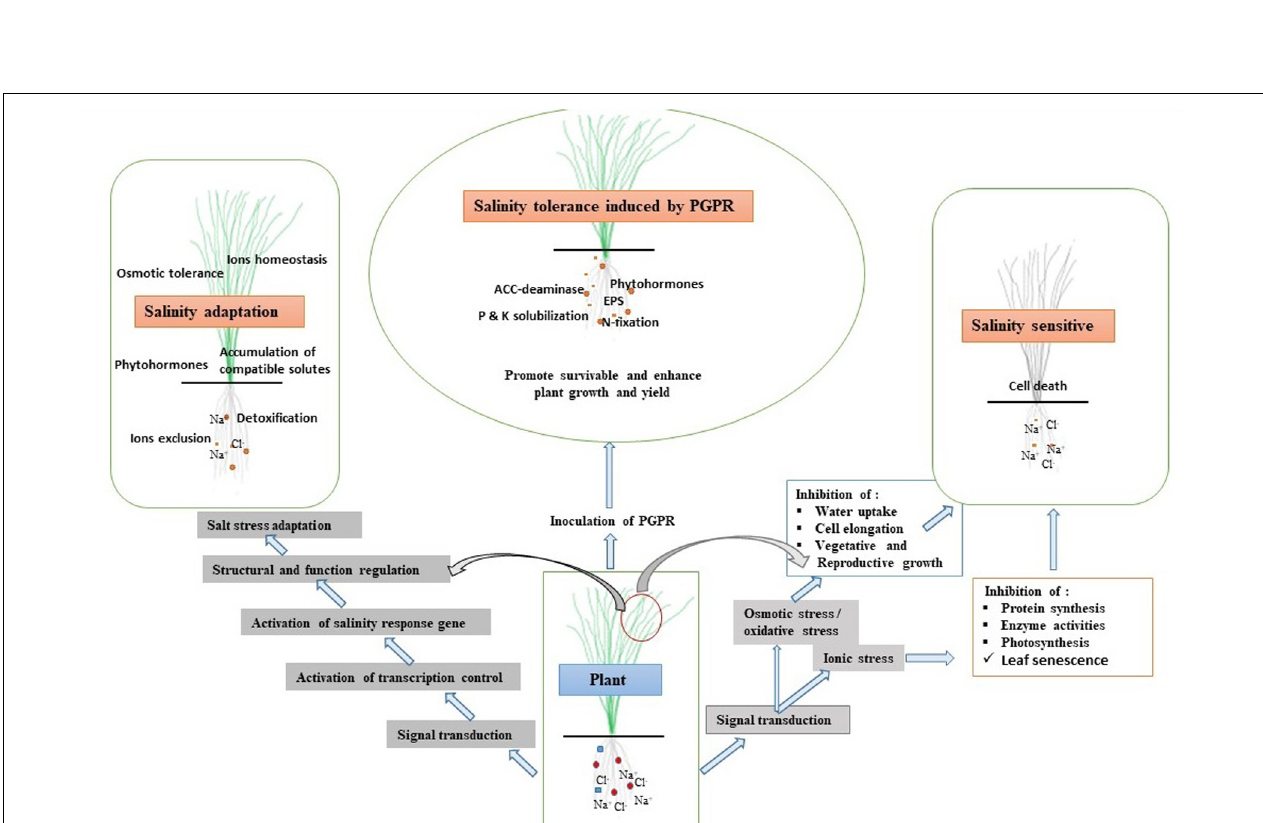
FIGURE 2 | Effects of salinity stress on plant signaling mechanism, adaptation, and PGPR-induced stress tolerance.